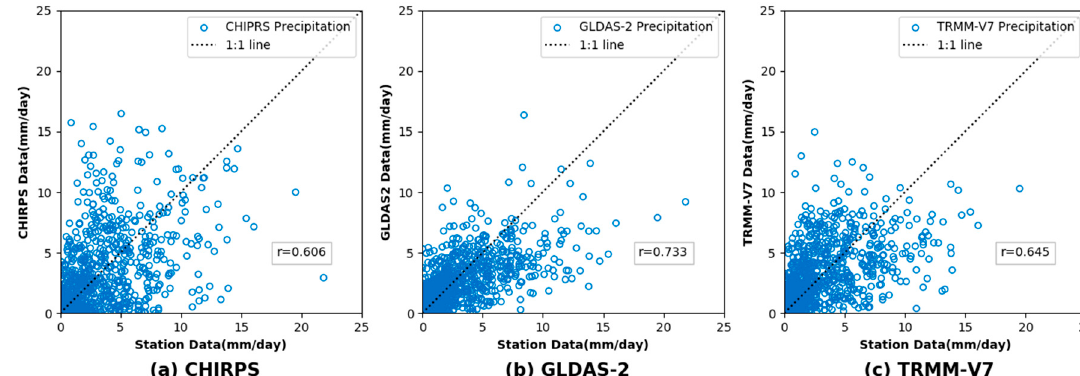
Figure 3. Accuracy evaluation of grid precipitation data. ( a ) Daily average precipitation scatter plot of CHIRPS data and station data. ( b ) Daily average precipitation scatter plot of GLDAS-2 data and station data. ( c ) Daily average precipitation scatter plot of TRMM-V7 data and station data.